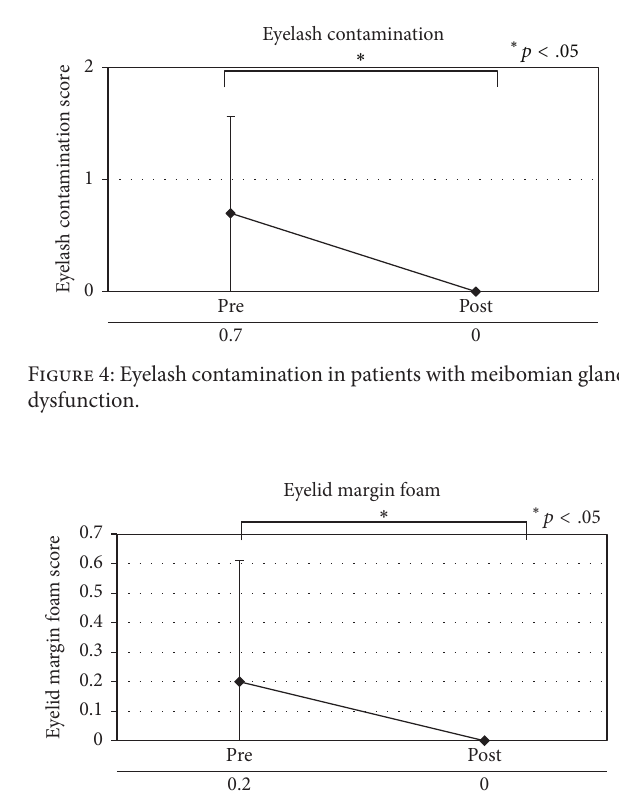
Figure 5: Eyelid margin foam in patients with meibomian gland